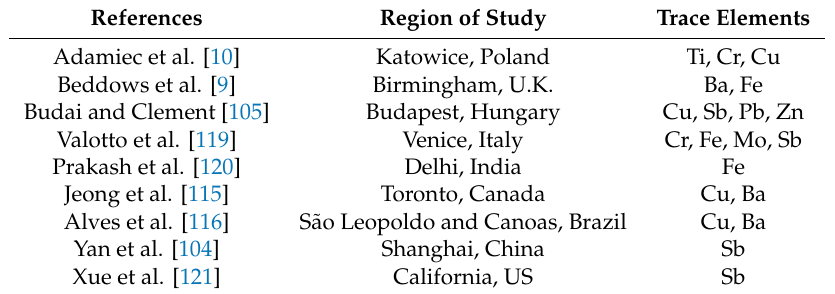
Table 5. Overview of common trace elements for particulate matter (PM) from road vehicle